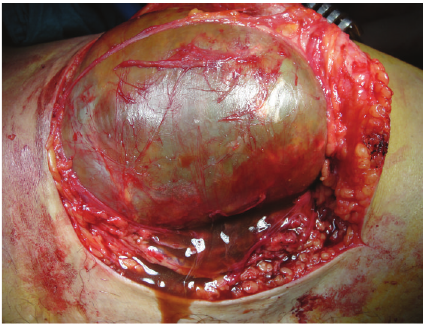
Figure 5: Intraoperative photograph of the mass and chocolate- brown fluid was seen.